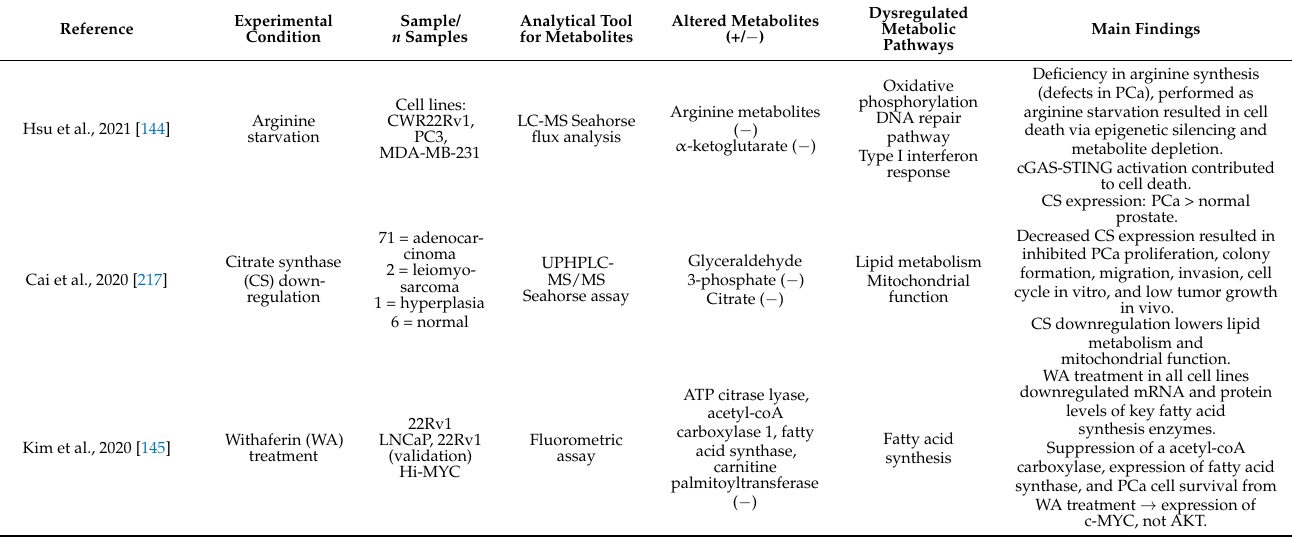
Table 1. Summary of genomic–metabolomic integration studies for PCa within the last decade (2011–2021) 1,2